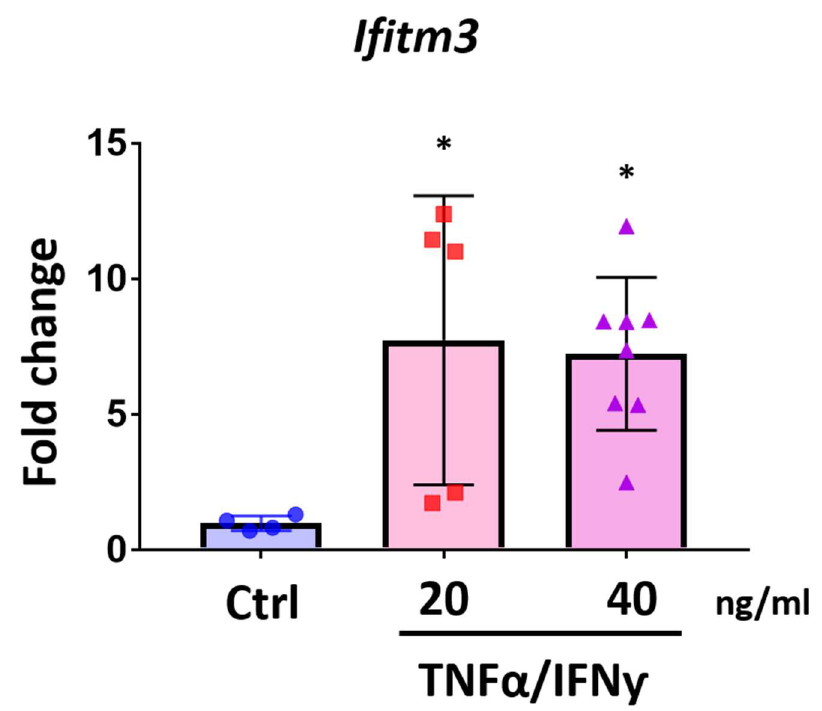
Figure 8. Ifitm3 expression is increased in TNF α and IFN γ treated microglial cell line, Sim-A9 cells. Sim-A9 cells were treated with TNF α and IFN γ (20 ng/mL and 40 ng/mL) for 24 h. qRT-PCR was performed to measure gene expression for Ifitm3 . Ifitm3 level was significantly increased by TNF α and IFN γ ( n = 4–8). * p < 0.05 compared to control, one-way ANOVA with Tukey’s post hoc